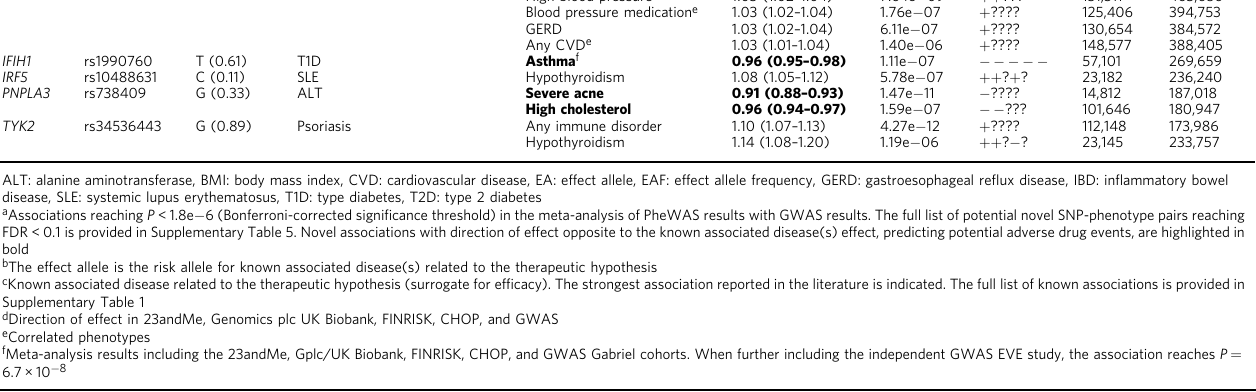
Novel association in meta-PheWAS